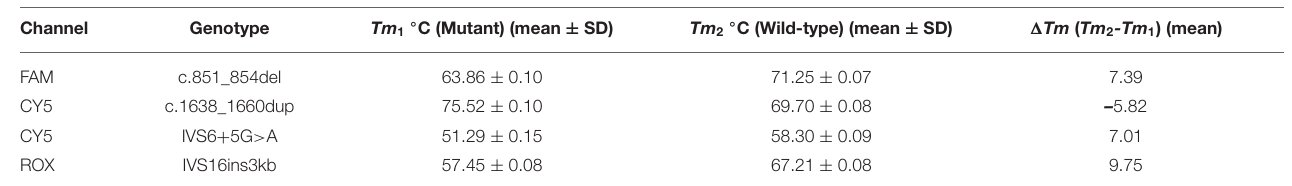
TABLE 2 | The Tm value of the four prevalent SLC25A13 mutations in the MMCA Assay. Channel